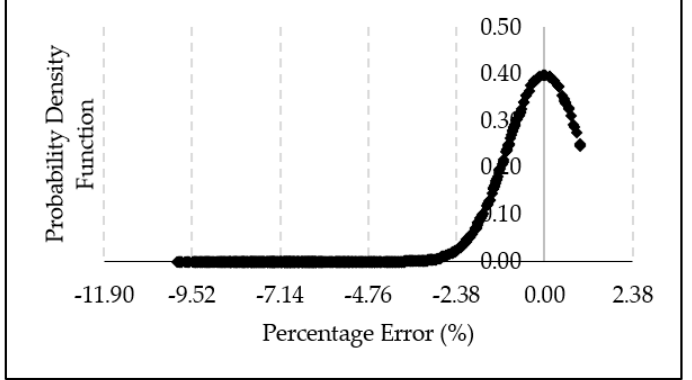
Figure 7. Probability distribution of the percentage error obtained using the new empirical failure pressure assessment method and FEM based on the parameters of the ANN training data.